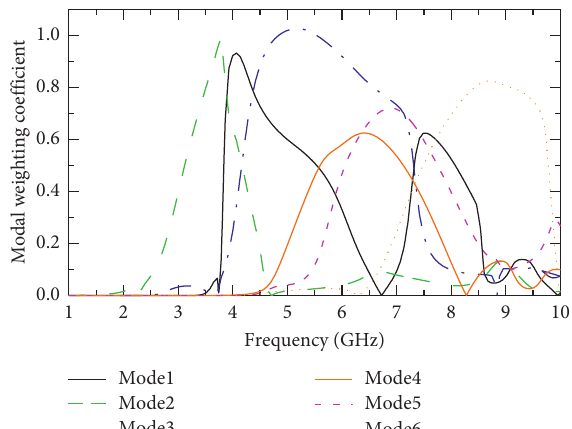
Figure 7: |MWC| for the first six modes excited by the CPW-fed